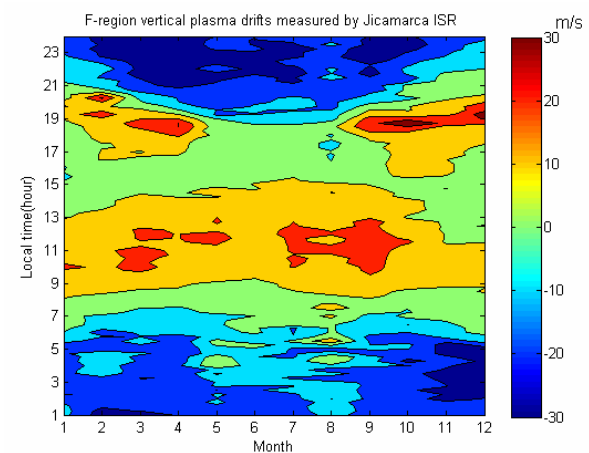
Figure 8. Monthly average of equatorial vertical plasma drifts measured by Jicamarca incoherent scatter radar (ISR) in unit of m/s. Fig. 8. Monthly average of the equatorial vertical plasma drifts measured by the Jicamarca incoherent scatter radar (ISR) in units of